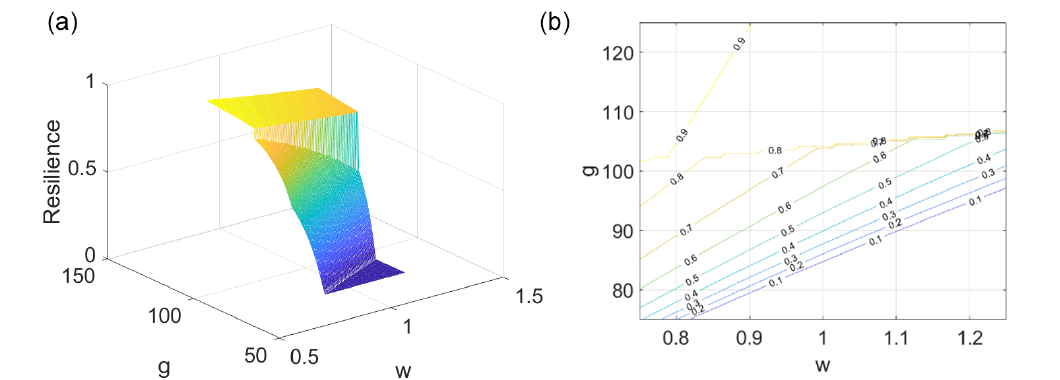
Figure 2. Variation of R system of a CIS with a fixed policy ( C,y ) over 10000 settings associated with uncertainty characterized by { g ∈ [75 , 125] ,w ∈ [0 . 75 , 1 . 25] } : (a) R system surface and (b) R system contours. The values of R system are used to calculate the mean, µ R and the below-mean mean, µ R<µ . In this particular case, the resilience does not change much when g is greater than about 100, but becomes more sensitive to both g and w when g is lower than